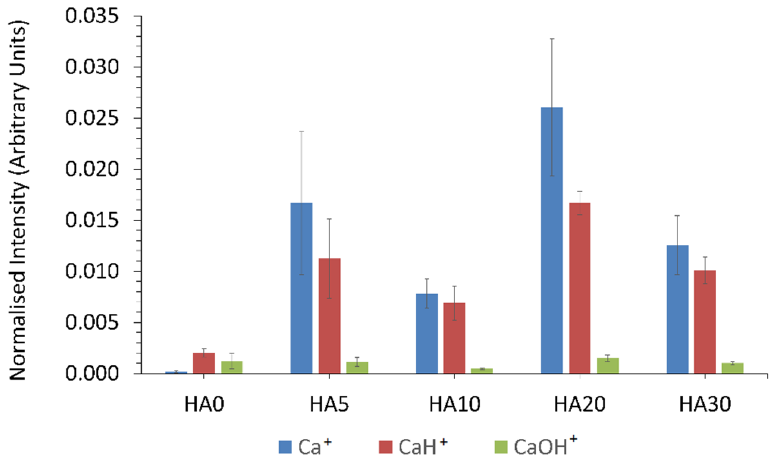
Figure 9. ToFSIMS normalised ion intensity for the surface of the samples.